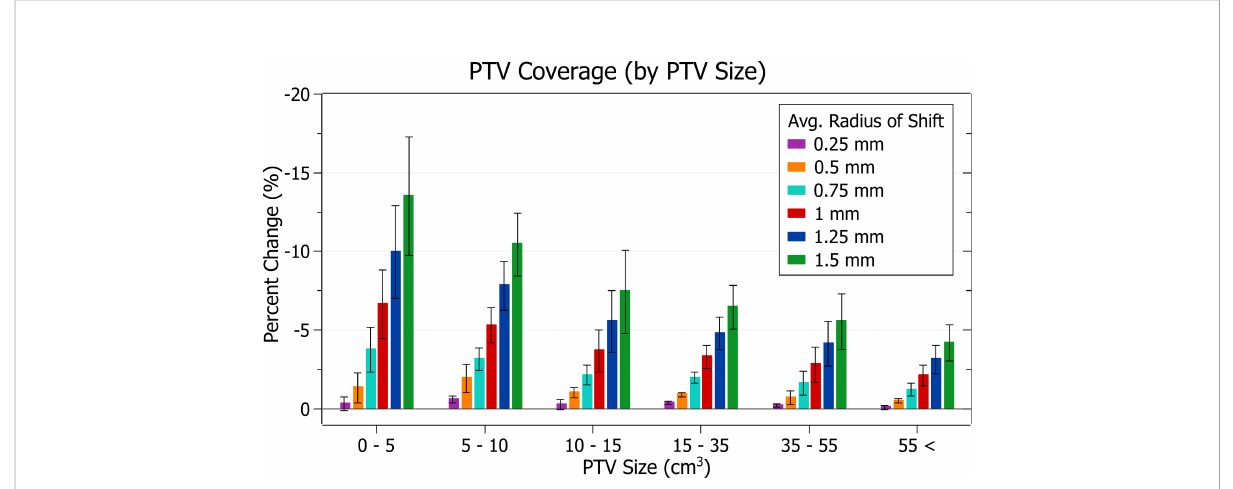
FIGURE 5 Average percentage change of PTV coverage for different radii of isocentre shift, categorised by PTV